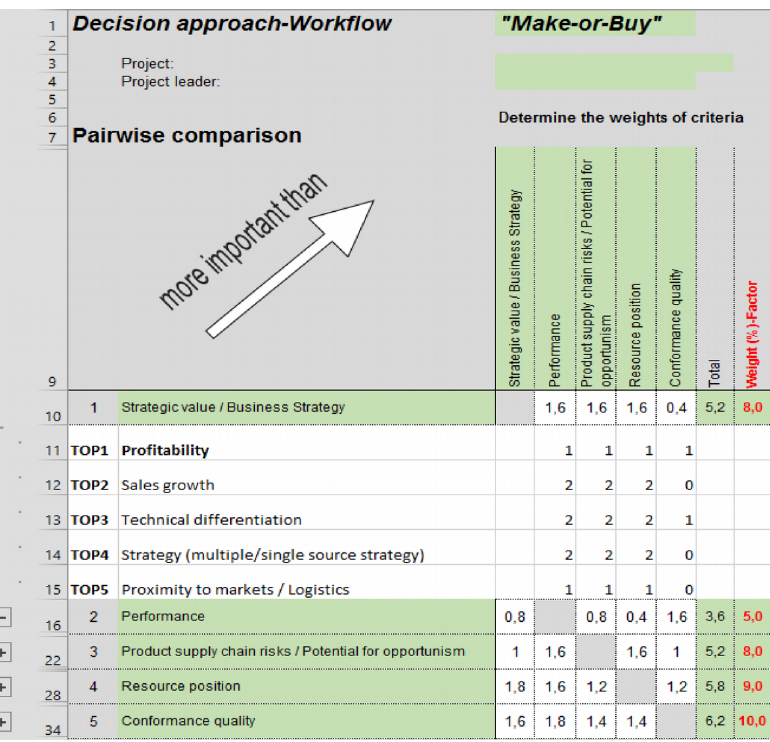
Figure 2. Pairwise comparison, case study